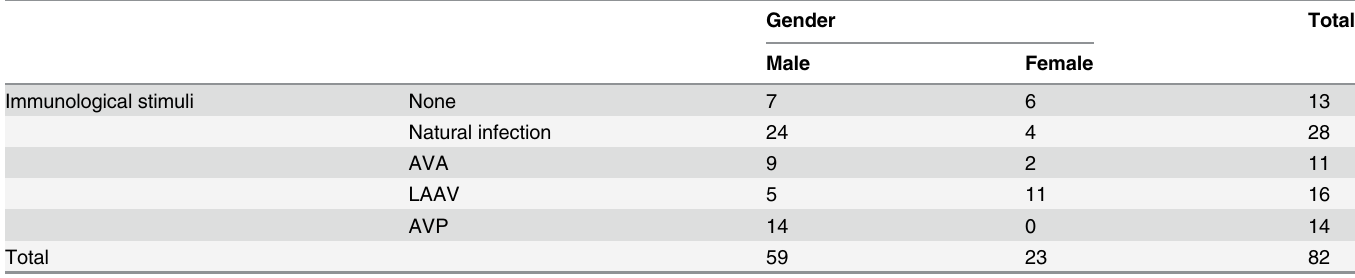
Table 1. Frequency of gender between groups in study including individuals with no history of Anthrax, recent Anthrax infection, or one of three different vaccines.